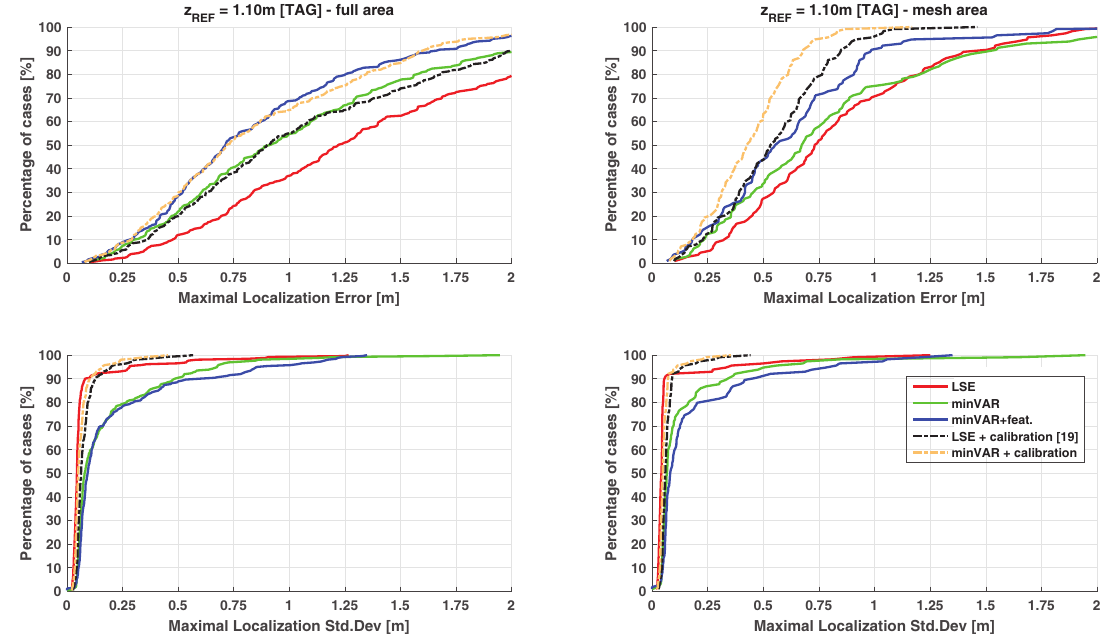
Figure 16. Cumulative distribution functions (CDFs) using the reference map @ z REF = 1.10 m = z TAG